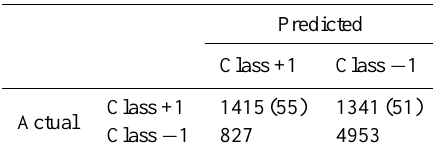
Table 5. Nearest Neighbours model: contingency table for the validation dataset. Numbers in brackets refer to real